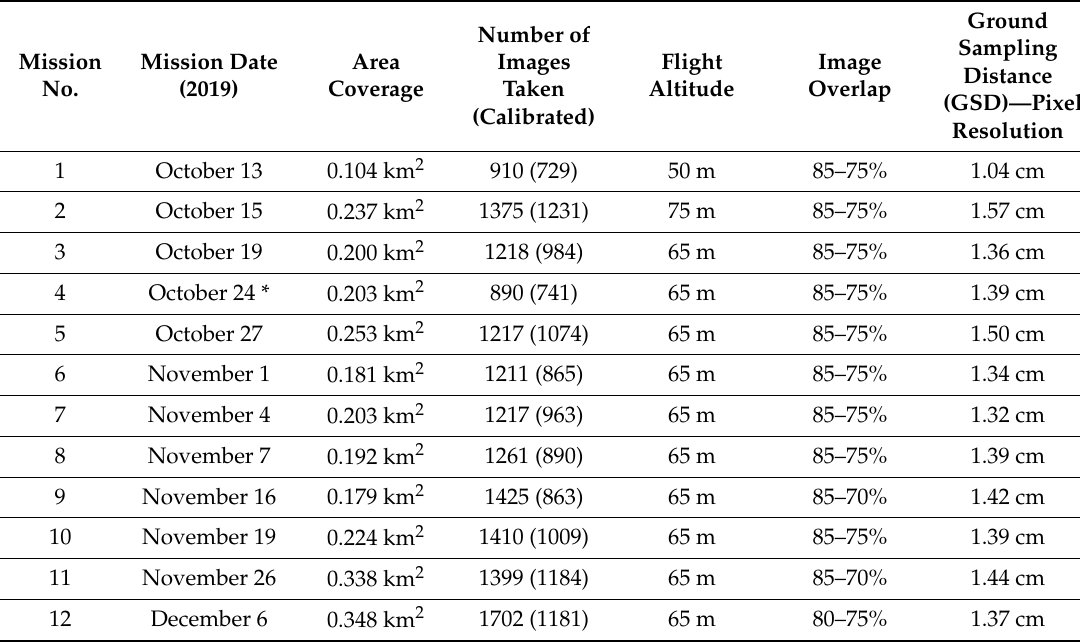
Table 1. Unmanned aerial vehicle (UAV) flight